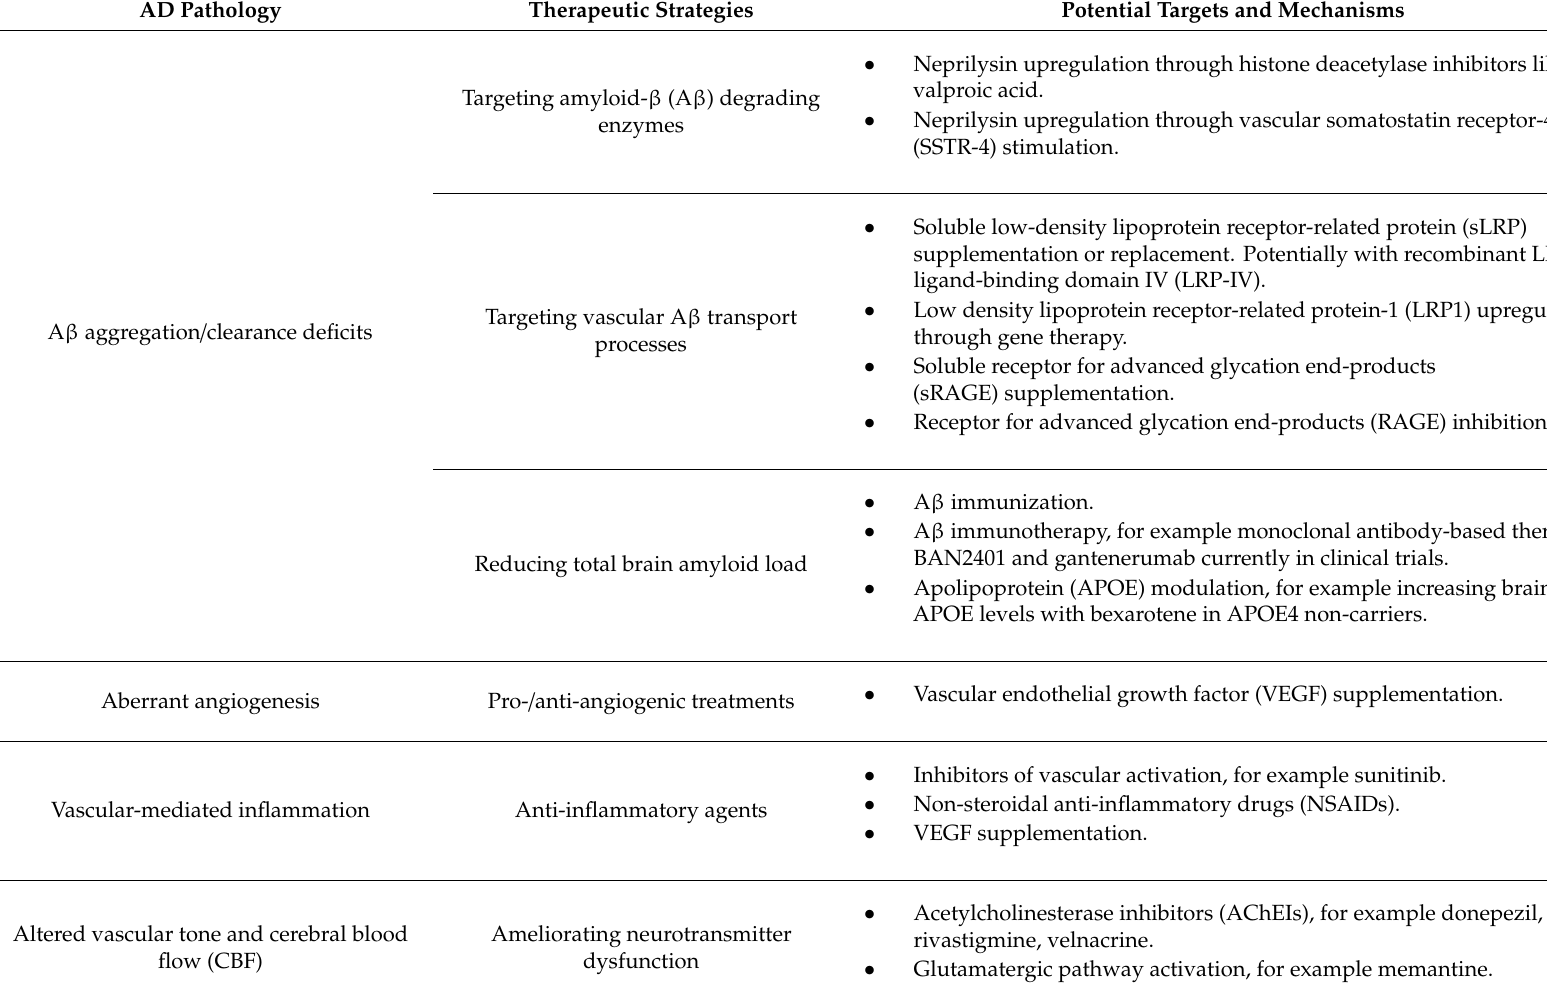
Table 1. The therapeutic targeting of vascular dysfunction in Alzheimer’s disease (AD)—some potential targets and